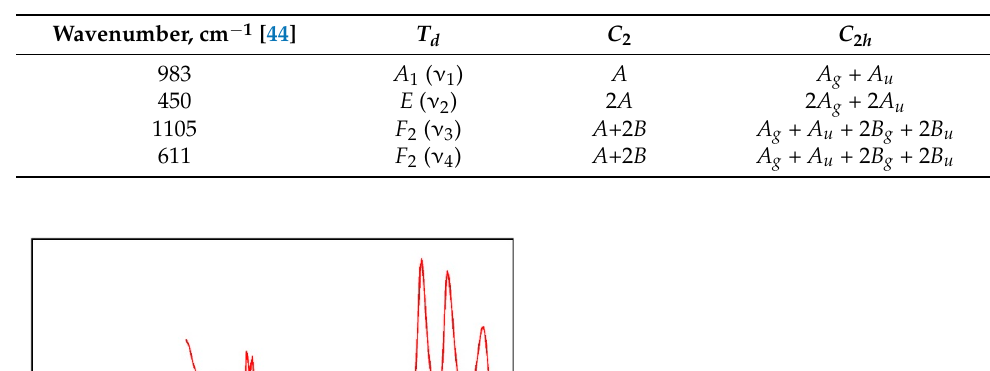
Table 2. Correlation between internal vibrations of SO 4 tetrahedra in Y 2 O 2 SO 4 .